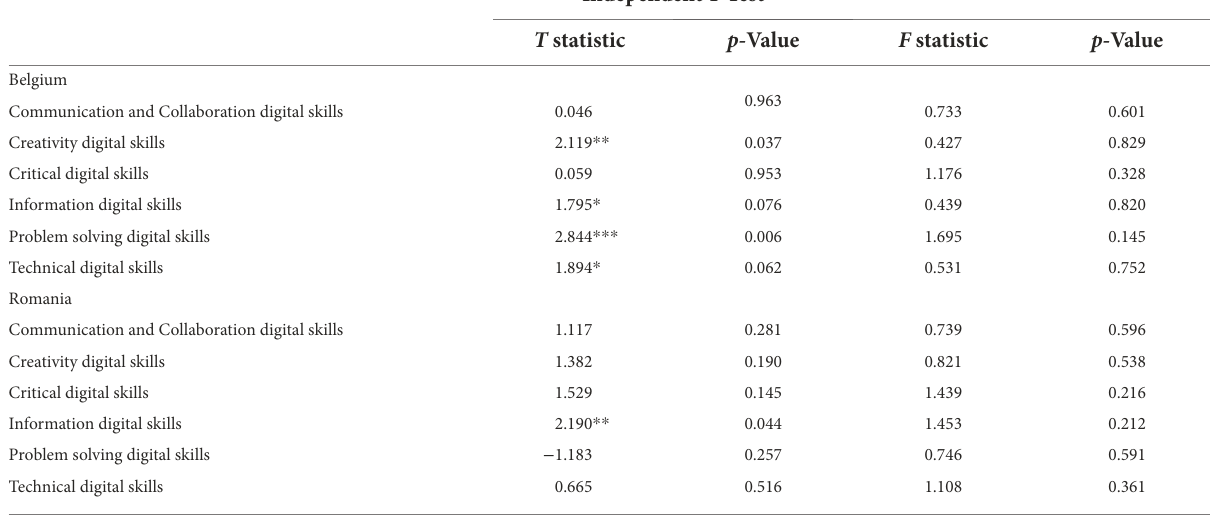
TABLE 5 Results of Independent T Test and ANOVA test for each type of digital skills.